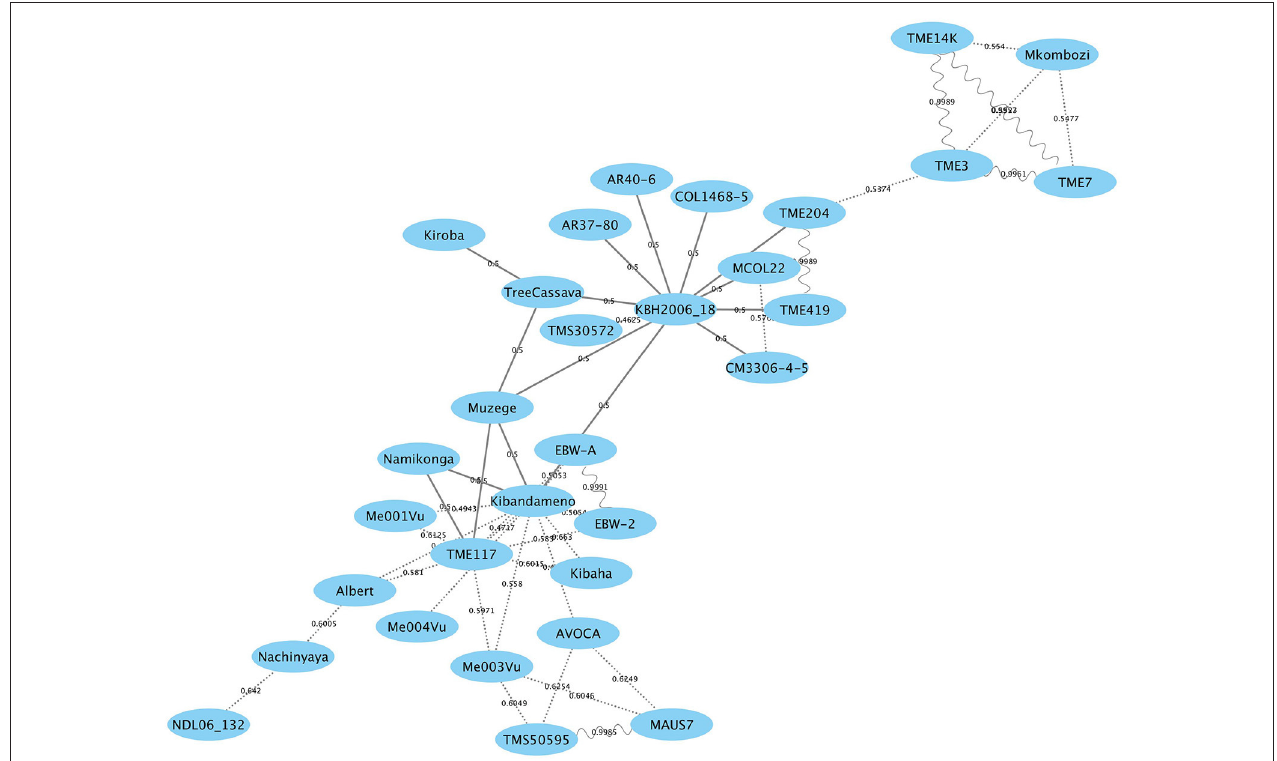
FIGURE 6 | Genome-wide relationship between Kiroba and other genotypes with estimated kinship coefficients ( ˆ π ) shown on the connecting lines. Parent–offspring relationship is represented by a solid line, full-siblings by dotted lines and identicals by sinewave (modified from Bredeson et al., 2016; Permission for the modification and publication of the adapted figure has been obtained from the copyright